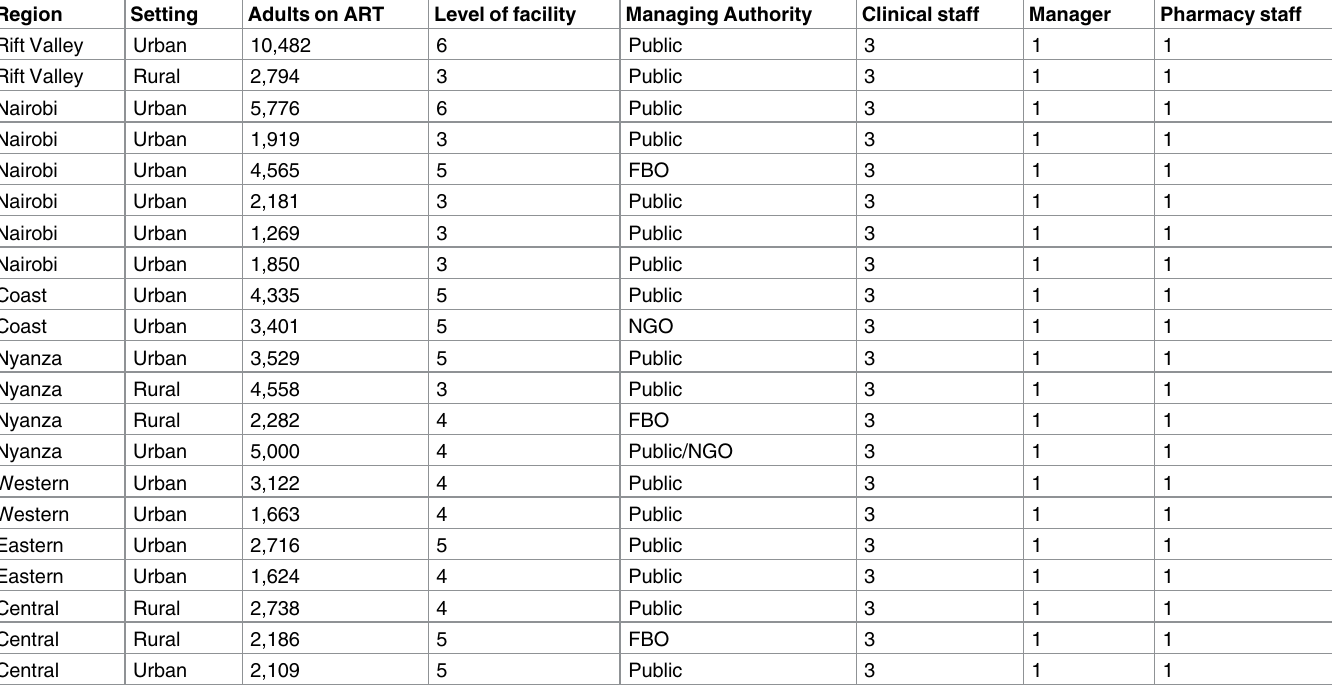
Table 1. Health facility characteristics and targeted staff mix for in-depth